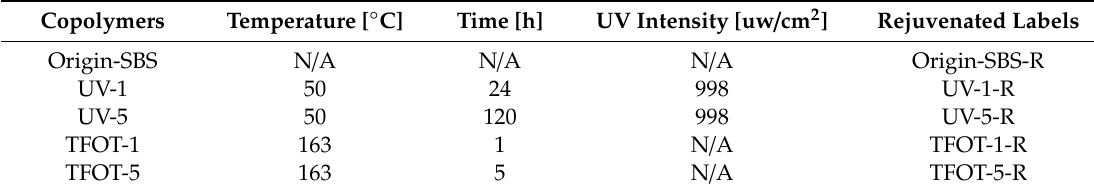
Table 4. Test samples and labels.